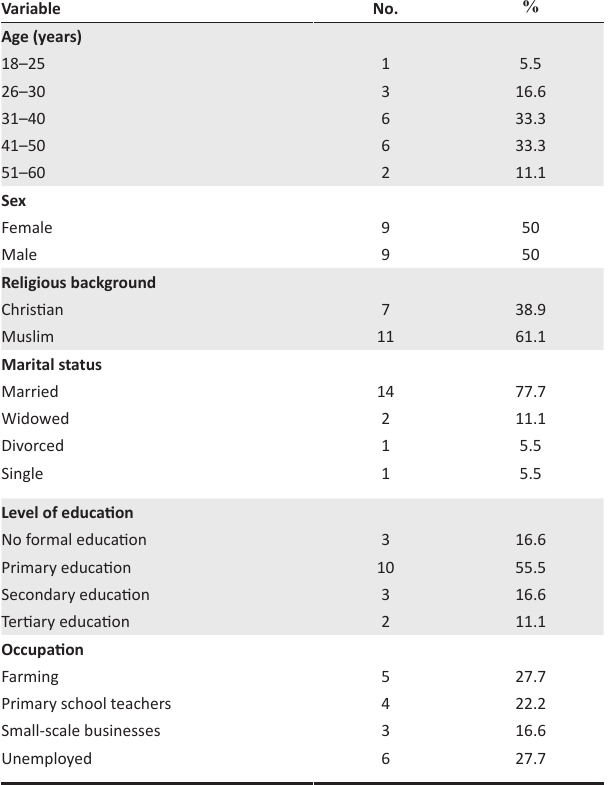
TABLE 1: Demographic data of the 18 participants interviewed. Variable